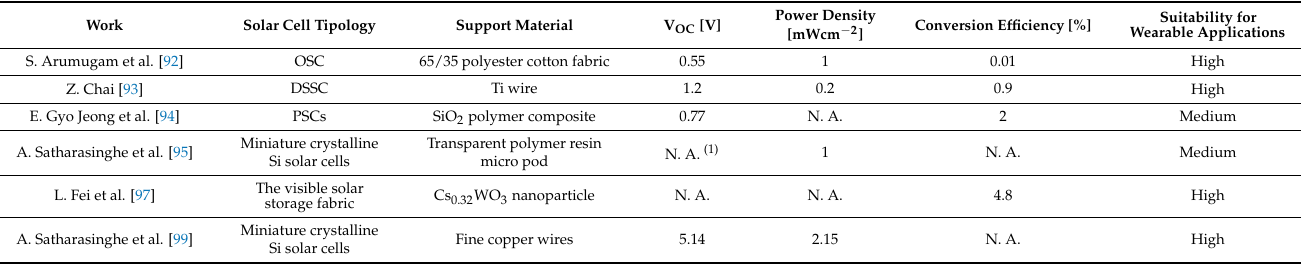
Table 6. Comparative table of solar fabrics for wearable